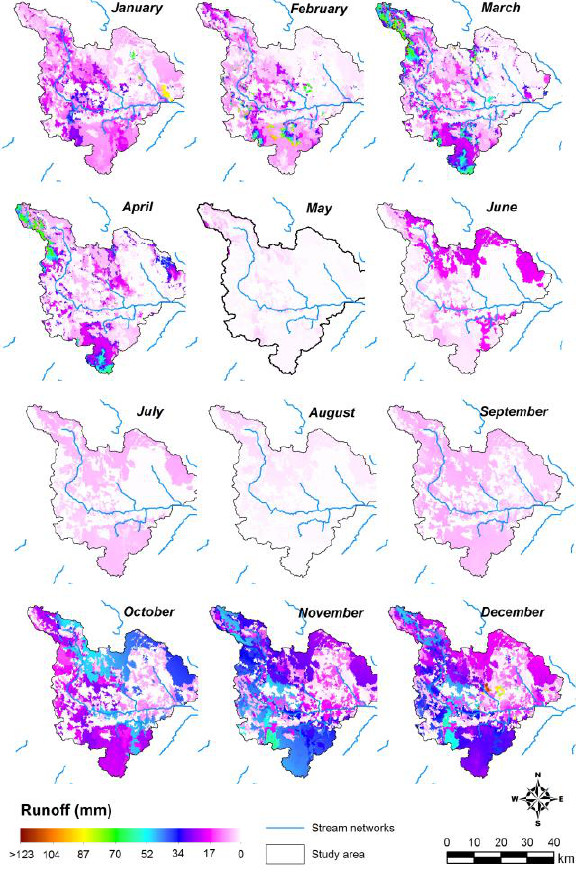
Figure 6. Monthly surface runoff maps derived from the PESERA Model Monthly surface runoff maps represented the spatial changes of surface runoff in Ermenek Subcatchment during a hydrological year. Surface runoff showed a significant increase during fall season in parallel to increasing rainfall. Summer months showed dry conditions within a significant water deficit that might affect the vegetation distribution remarkably. Annual and monthly surface runoff was also estimated using PESERA model within the study. The results of the surface runoff analysis on monthly basis were presented in Table